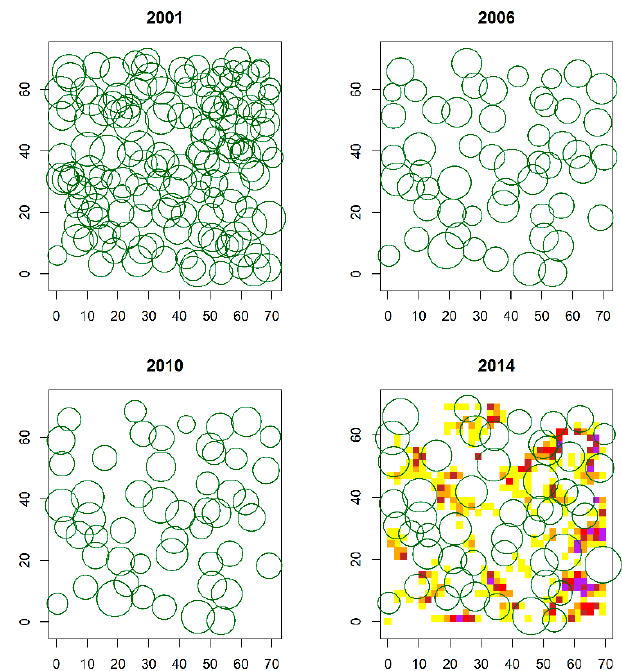
Figure 1. Location of adult trees (dbh ≥ 10cm; green circumferences proportional to tree diameter) in the half-hectare plot, and the number of saplings per 2 × 2 m quadrat (yellow: 0–5 saplings; orange: 6–10 saplings; brown: 11–15 saplings; red: 16–20 saplings; purple: > 21 saplings).